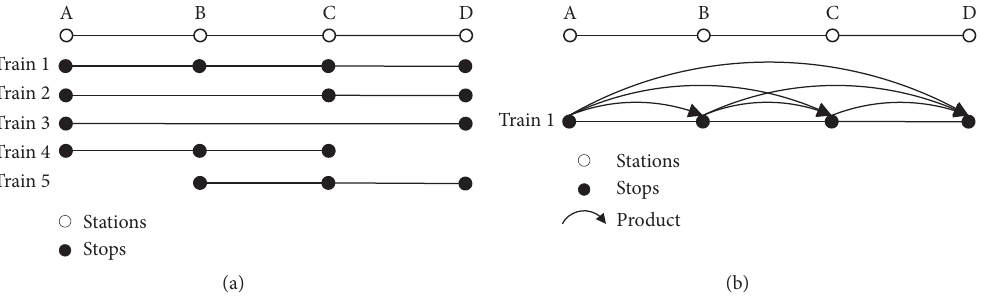
Figure 1: A multi-OD HSR with multiple train services. (a) Multiple trains serving a single OD. (b) A train serving multiple